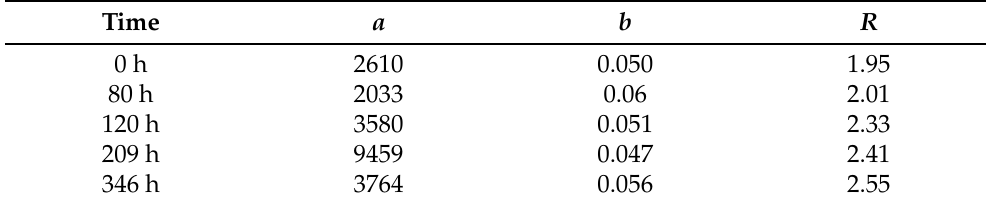
Figure 5. Parameters identification with polarization curve at t = 80 h. The internal model parameters identified at different time steps are listed in Table 1. Table 1. Degradation model parameters identification